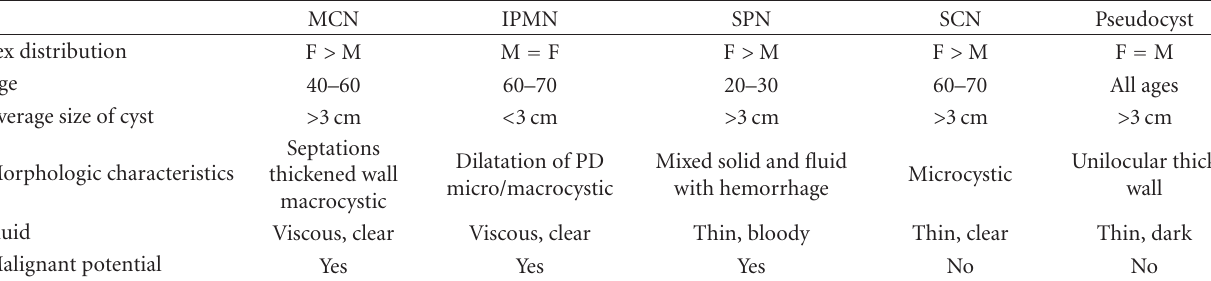
Table 2: Characteristics of di ff erent pancreatic